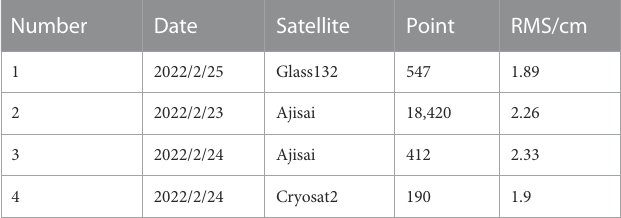
TABLE1MeasurementresultsofthepolarizedcoaxialforSLRatthePRFof2 kHz.